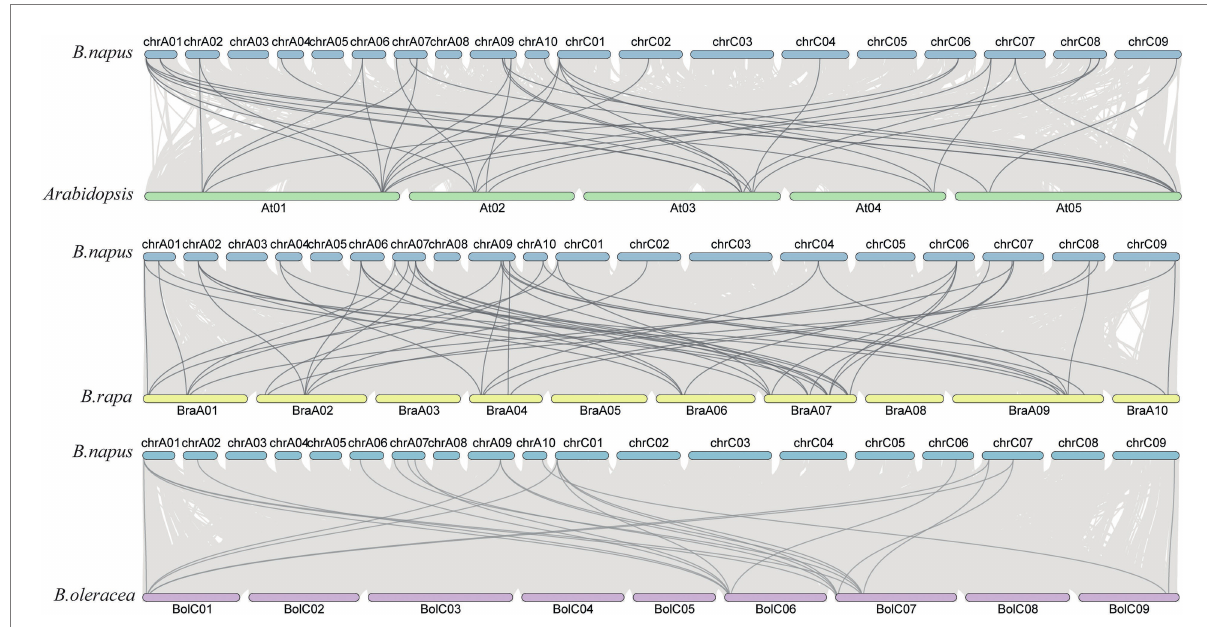
FIGURE 5 The collinear relationship of SHI/STYs on the chromosome. A chromosome is represented by a bar. The green, yellow, and purple bars represent the chromosomes of Arabidopsis , B. rapa , and B. oleracea , respectively. The collinear blocks (between the genomes of B. napus and Arabidopsis , B. napus and B. rapa , B. napus and B. oleracea ) were indicated in the gray